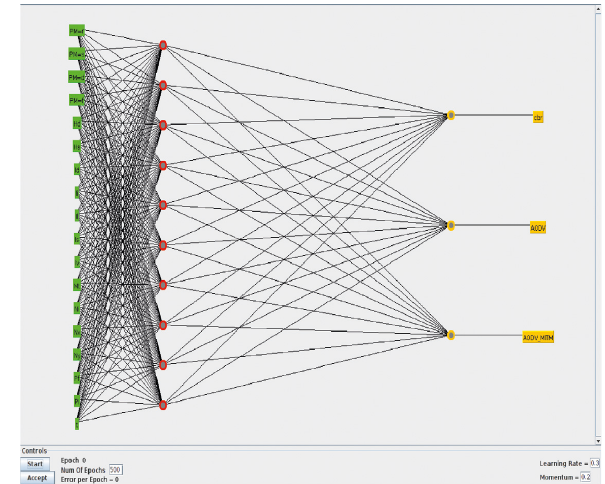
Figure 8: Initial ANN model generation for